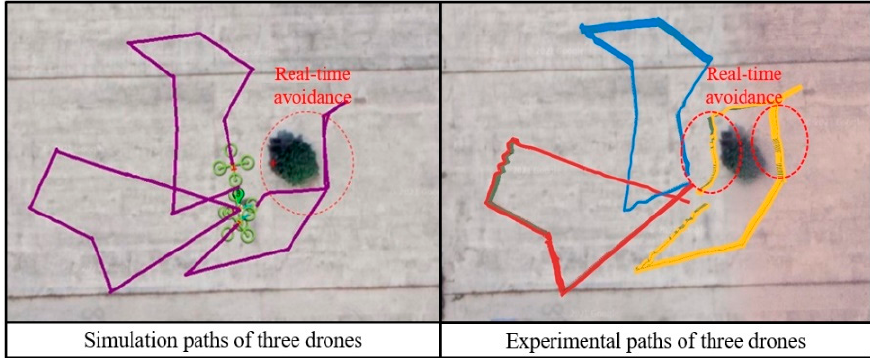
Figure 27. Comparison of simulated and experimental flight trajectories.